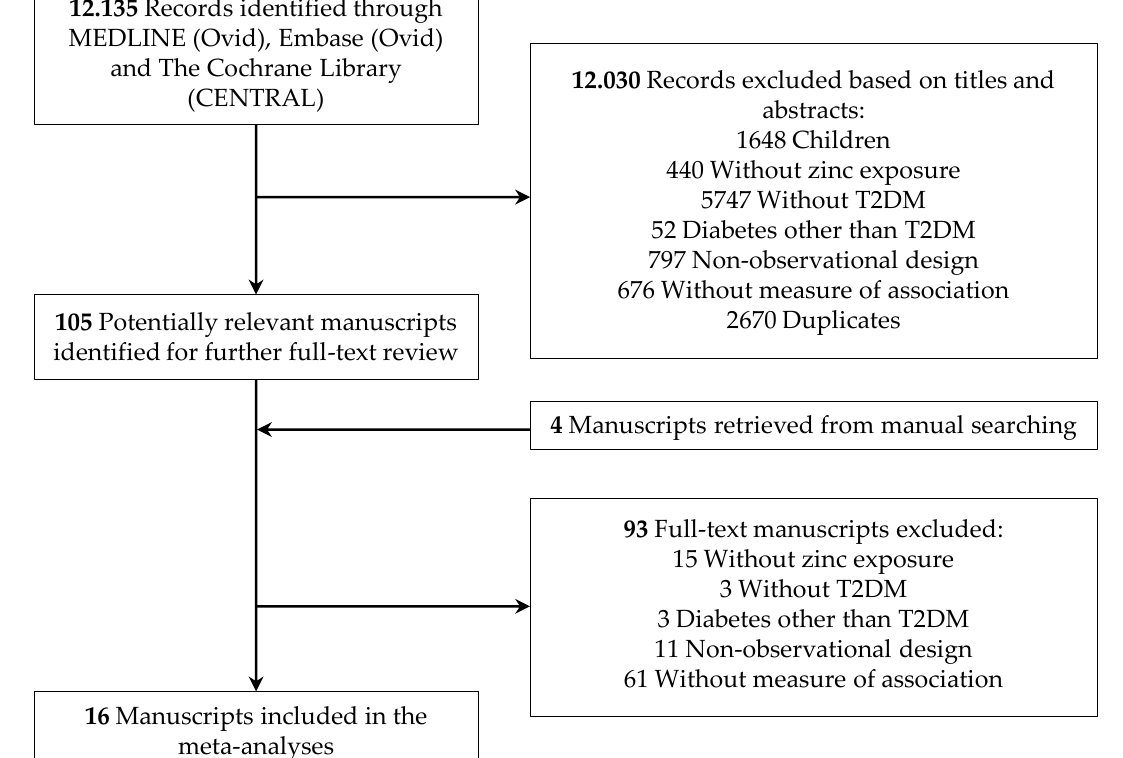
Figure 1. Flowchart of the selection